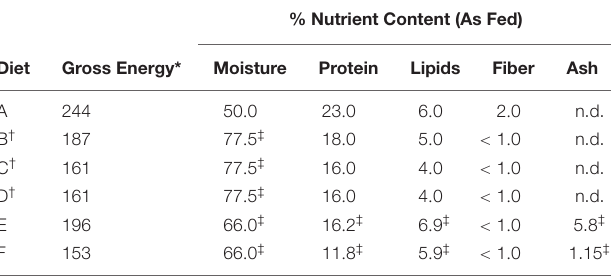
TABLE 3 | Nutrient content of feed trial